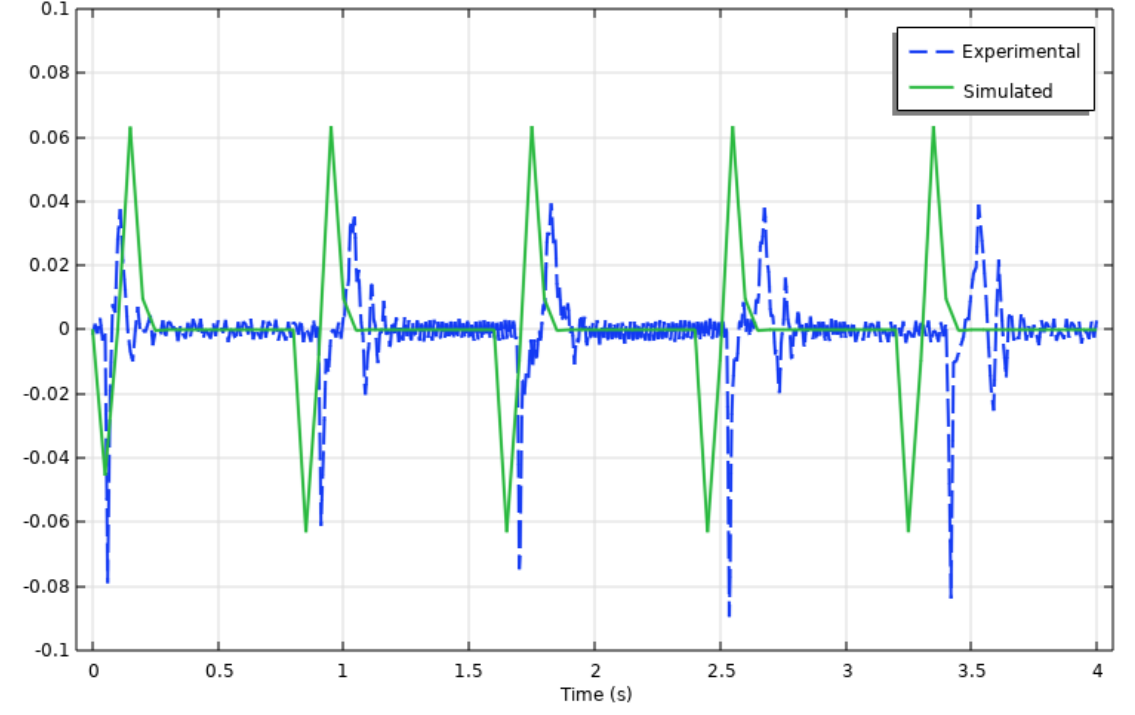
Figure 6. Experimental (dashed-blue) and FEA simulation (solid-green) voltage outputs from piezoelectric energy harvesting pacemaker lead wire for a cantilever setup with a tip displacement of 1 mm.